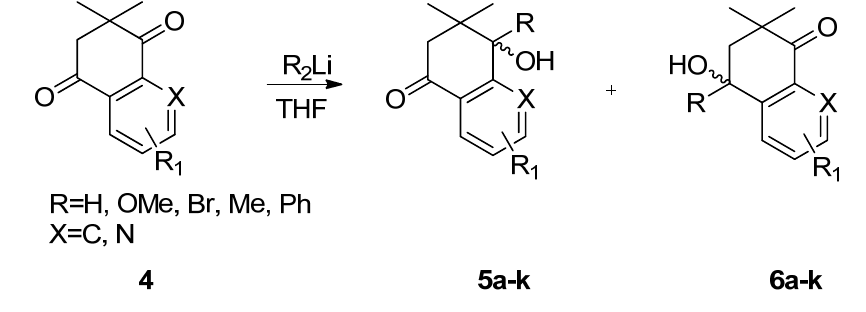
Table 4. Regioselective additions of acetylides to dimethyl